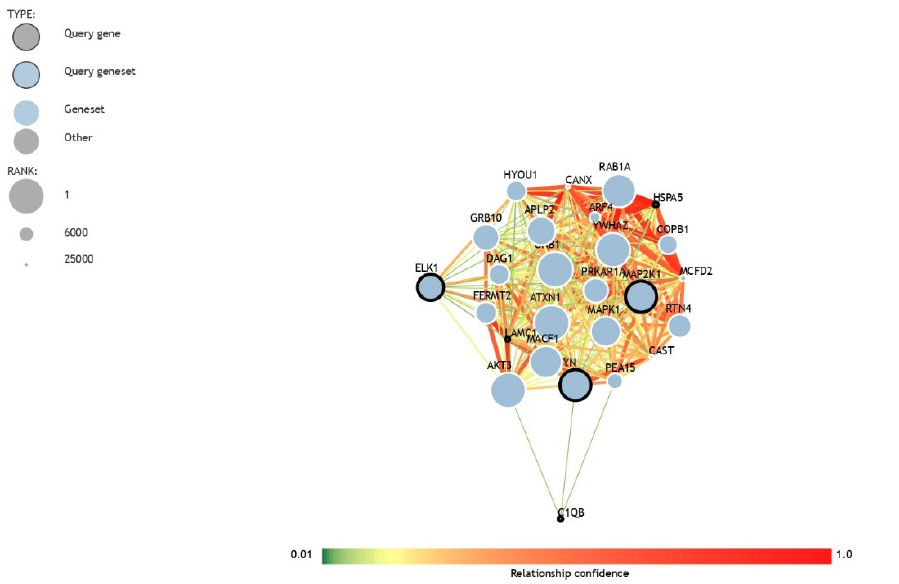
Figure 4. Network constructed using the differentially expressed genes in the ASD brain belonging to the “prion diseases” pathway using a minimum confidence score of 0.04 and a maximum of 20 interacting genes. Table 3. Top 10 genes interacting with ASD brain DEGs belonging to the “prion diseases” pathway. Query Gene